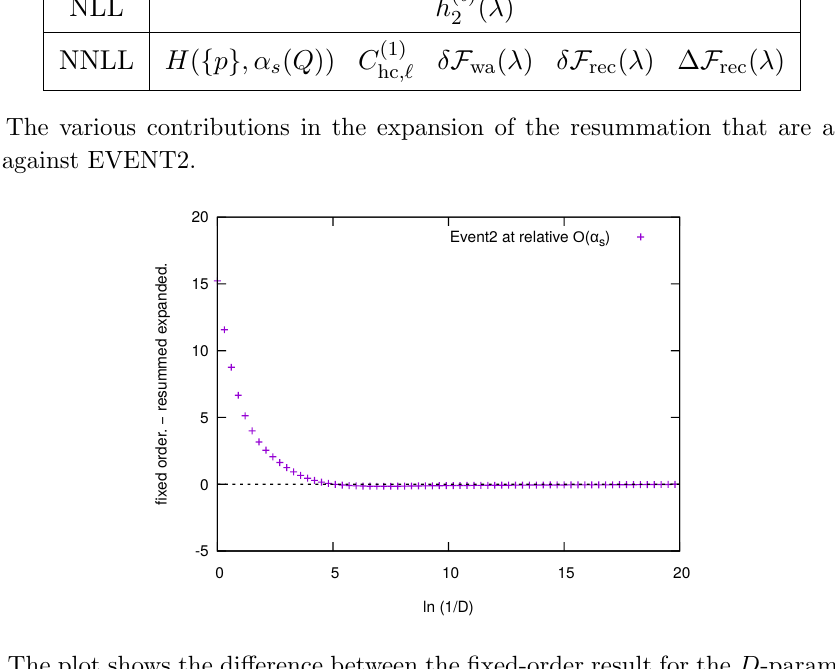
Figure 2 . The plot shows the di(cid:11)erence between the (cid:12)xed-order result for the D -parameter at LO, i.e. O ( (cid:11) 2 ), using EVENT2 and the expansion of the resummation from section s